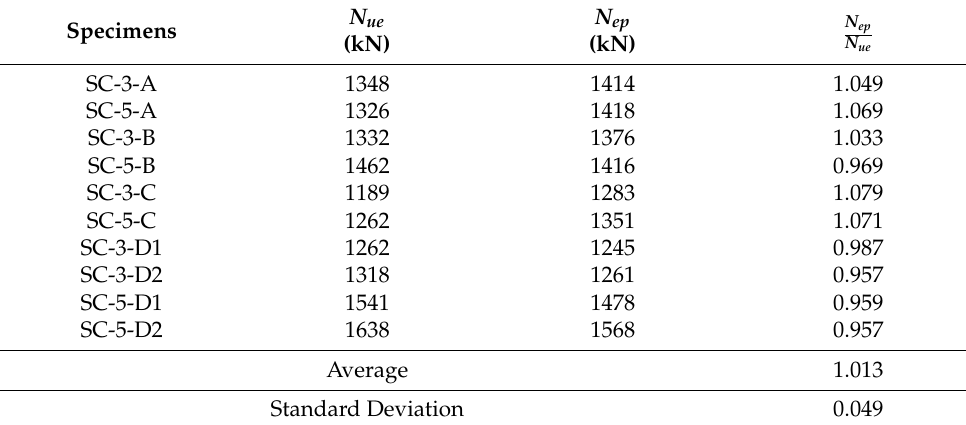
Table 1. Ultimate strength of finite element analysis and test